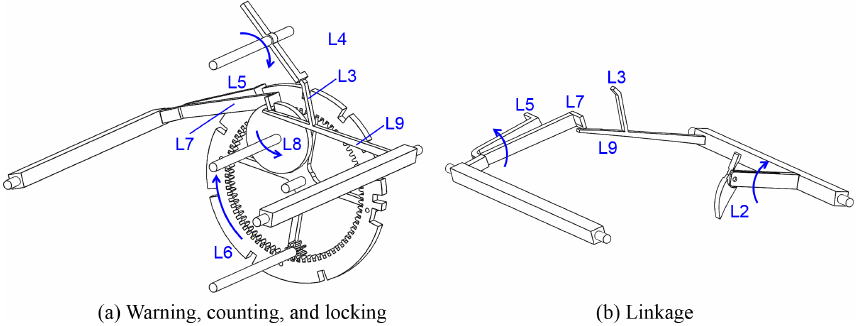
Figure 14. Structure and operation of the N4 striking trigger. (The trigger is similar to that of N2.)